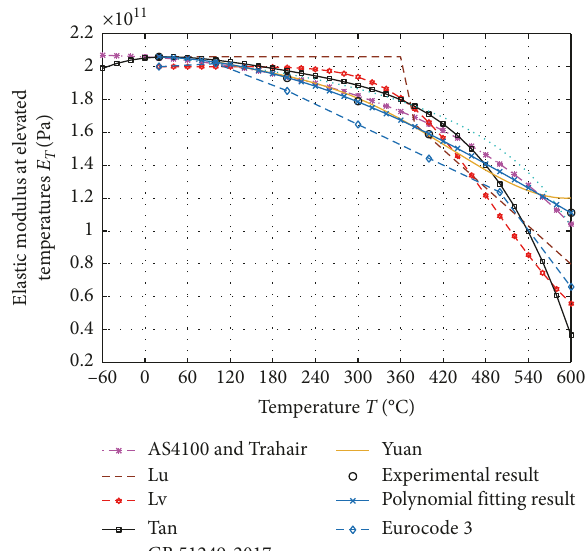
Figure 5: Relationships between the elastic modulus of steel and temperature for selected designs.